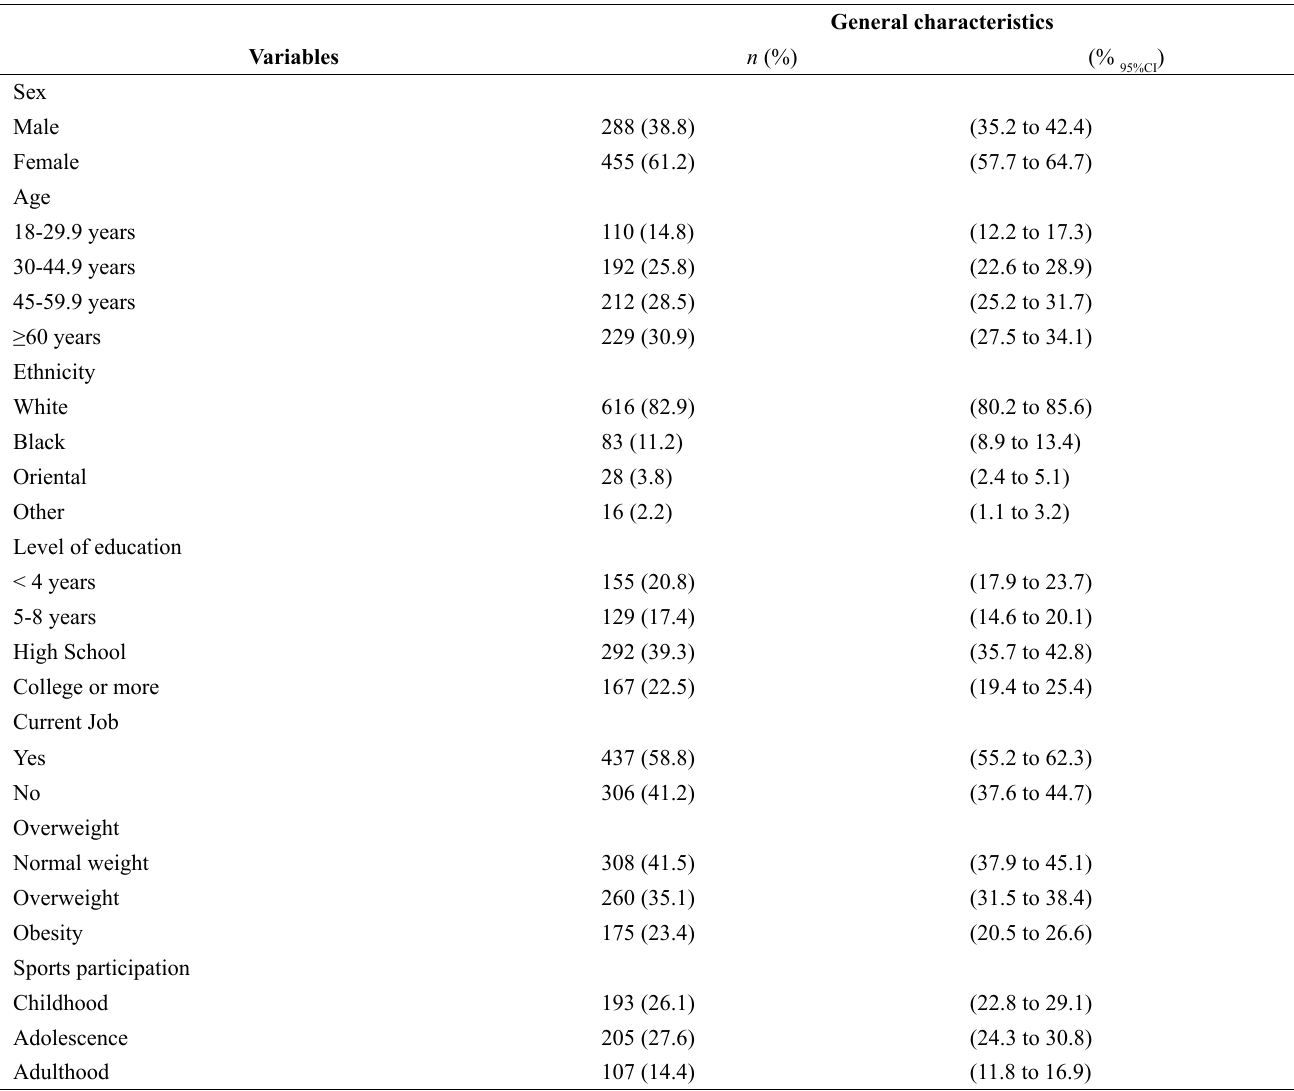
Table 1. Summary of the general characteristics of the